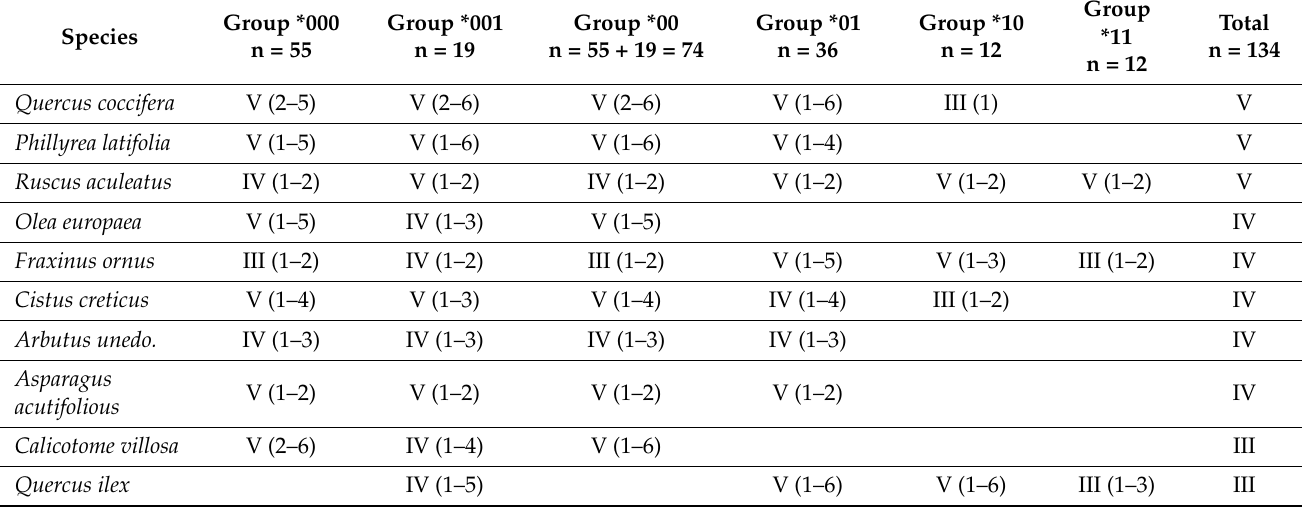
Figure 3. TWINSPAN classification dendrogram. The number of samples in each group is shown within the corresponding box. The indicator pseudospecies for each group are also shown. Community codenames are given in bold for each of the identified communities and sub-communities for convenience in the description and further analysis. Table 2. Species frequencies and abundance range for the groups identified to form communities or sub-communities. Only the constant and frequent species of each group are shown. For the explanation of frequencies and abundance symbols see Section